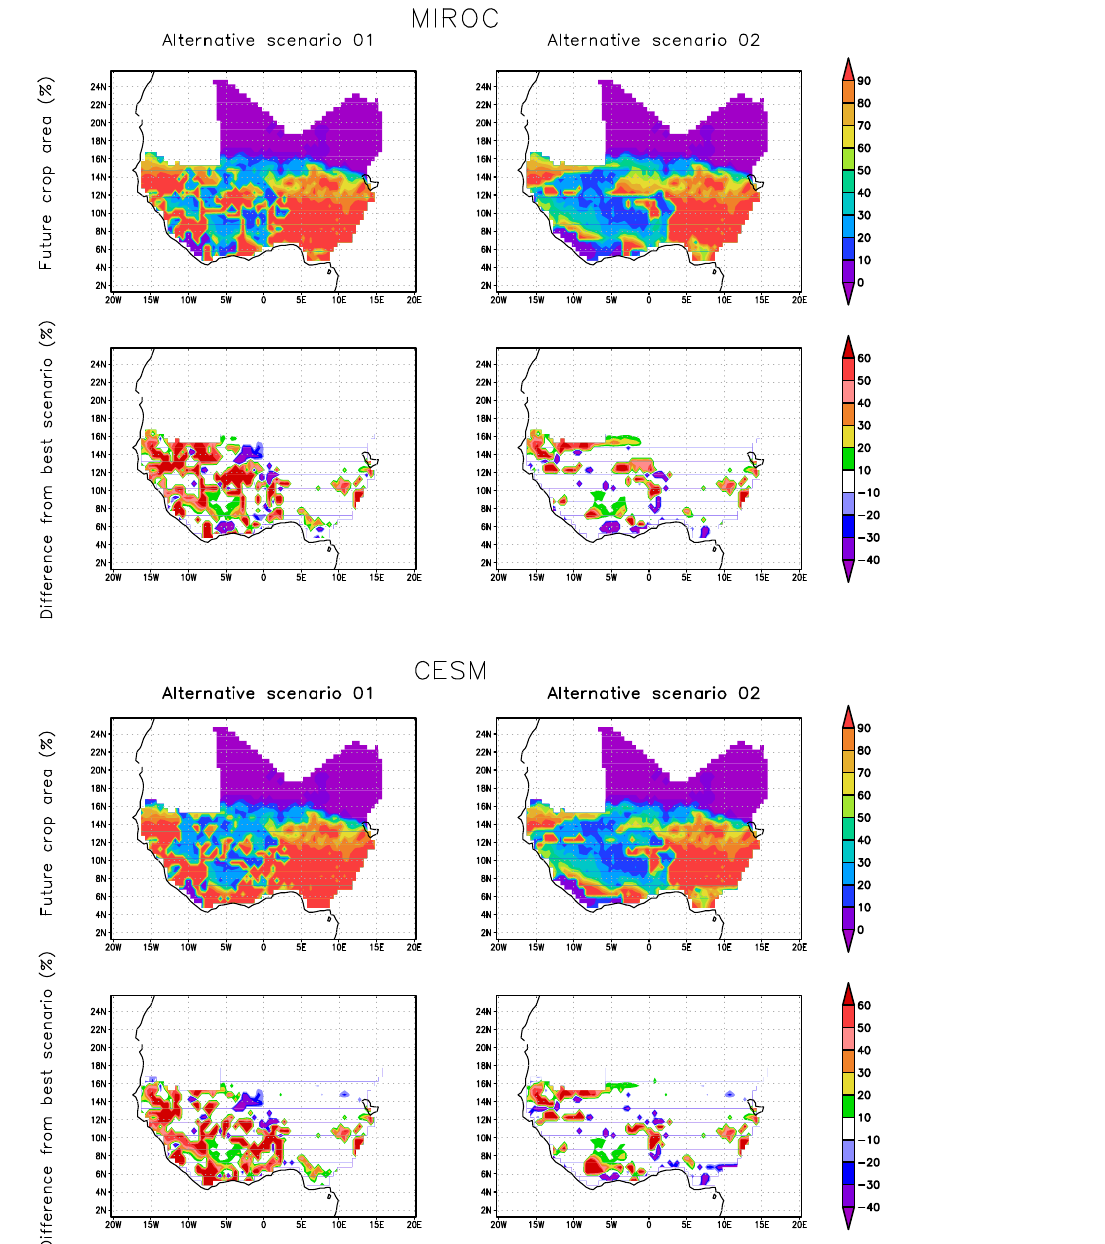
Figure 6. Future crop area percentage (first and third rows) in West Africa (under the MIROC- and CESM-driven regional climates) projected by the LandPro algorithm following two alternative scenarios of selecting grid cells for conversion to agricultural land based on the order of yield, and their respective differences (second and fourth rows) relative to the initial run (best scenario) that follows the descending order of yield. Alternative scenario 1: ascending order of yield; alternative scenario 2: random